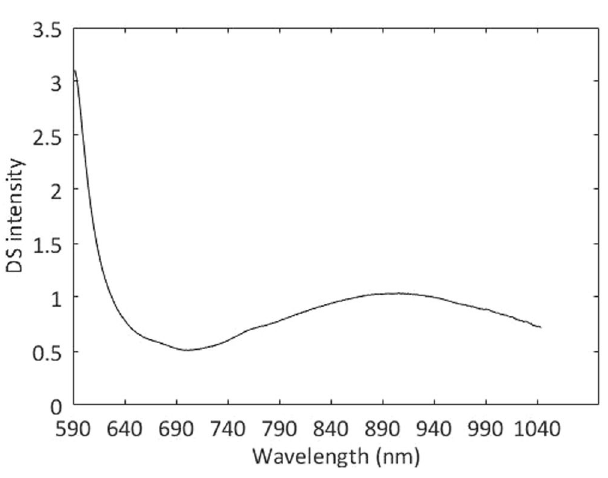
Figure 6. DS signal extracted from one